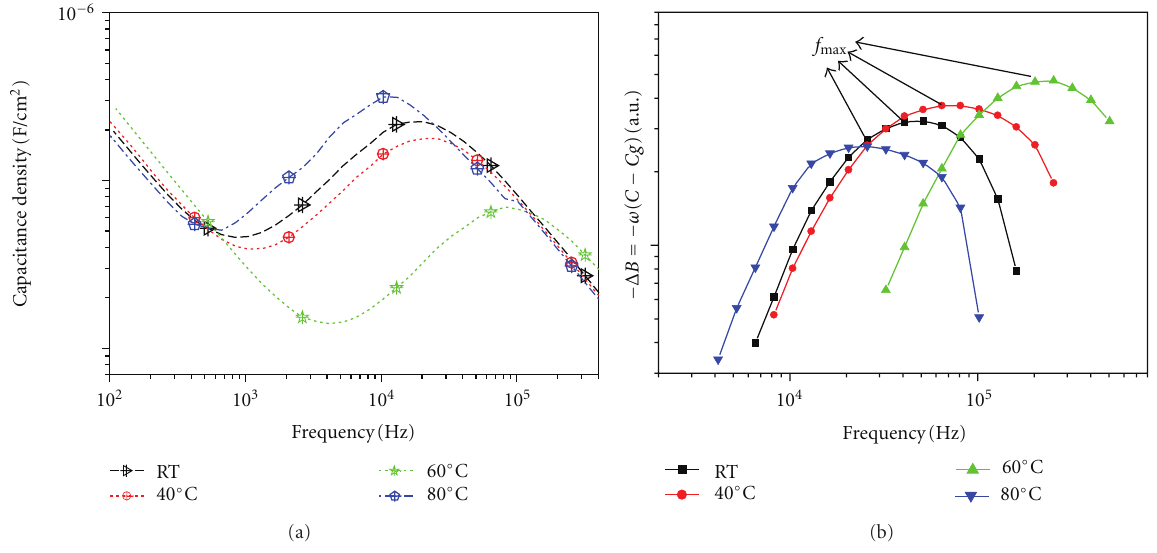
Figure 10: (a) Frequency spectra of capacitance and (b) negative di ff erential susceptance for ITO/PEDOT:PSS/PFE:BNDI (3:1)/Al device at di ff erent temperatures under 1mW/cm 2 at 368